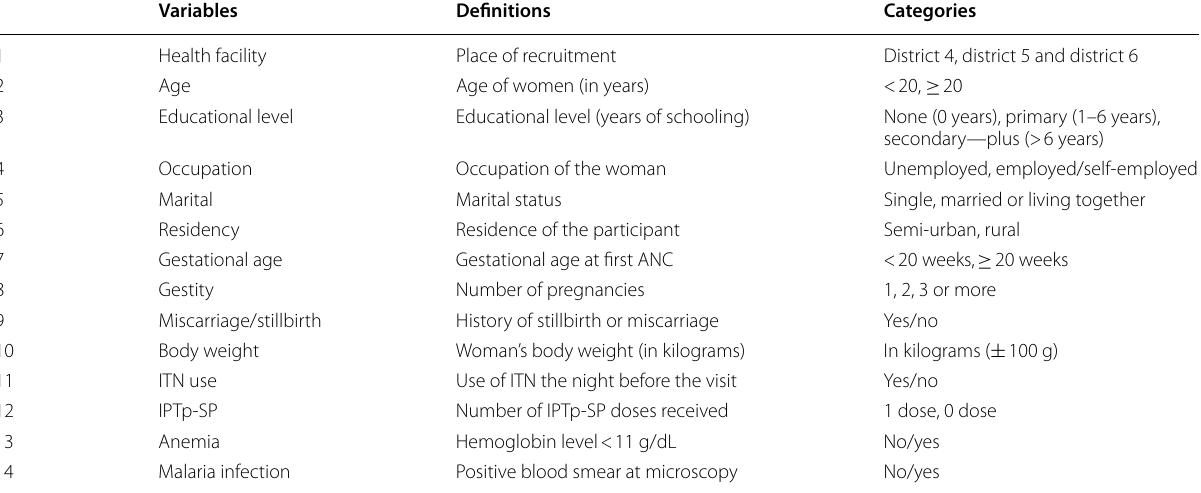
Table 1 List and definition of